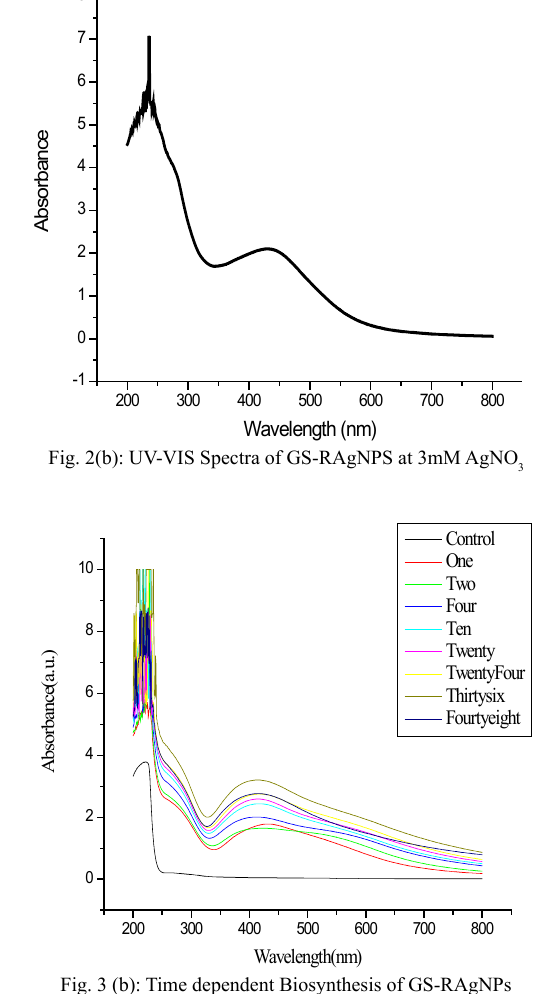
Fig. 3 (b): Time dependent Biosynthesis of GS-RAgNPs